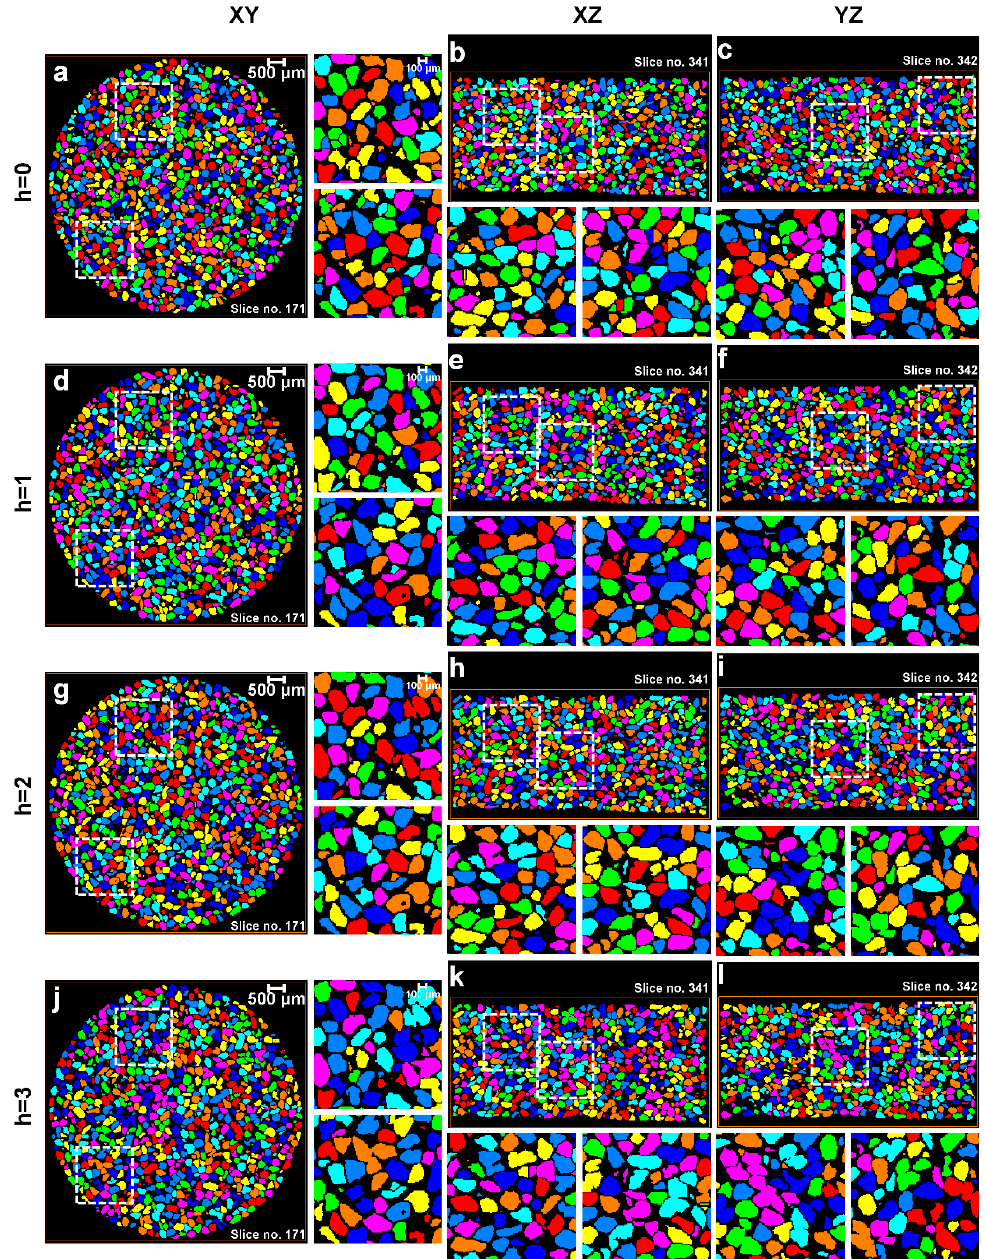
Figure 11. Separation outcomes (XY, XZ, and YZ views through the centre of the sand volumes) for the sand volume compressed under 8 MPa stress and separated using the watershed method with a h -value of: ( a – c ) h = 0; ( d – f ) h = 1; ( g – i ) h = 2; and ( j – l ) h = 3.